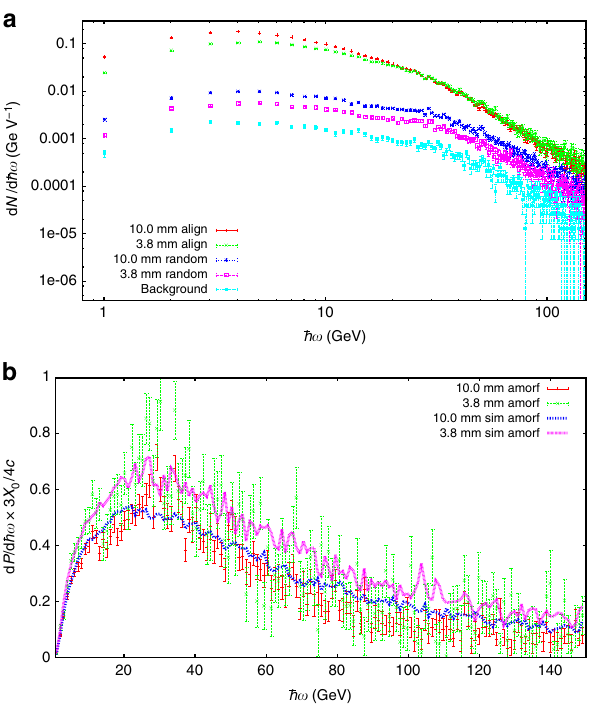
Fig. 3 Experimental and simulated power spectra. Background subtracted power spectra in the aligned case for two crystal thicknesses: 3.8 mm ( a ) and 10.0 mm ( b ). The experimental data are compared to the four different theoretical models, described in Supplementary Note 1, after being translated through the simulation of the experimental setup. The error bars are due only to the statistical counting error in each